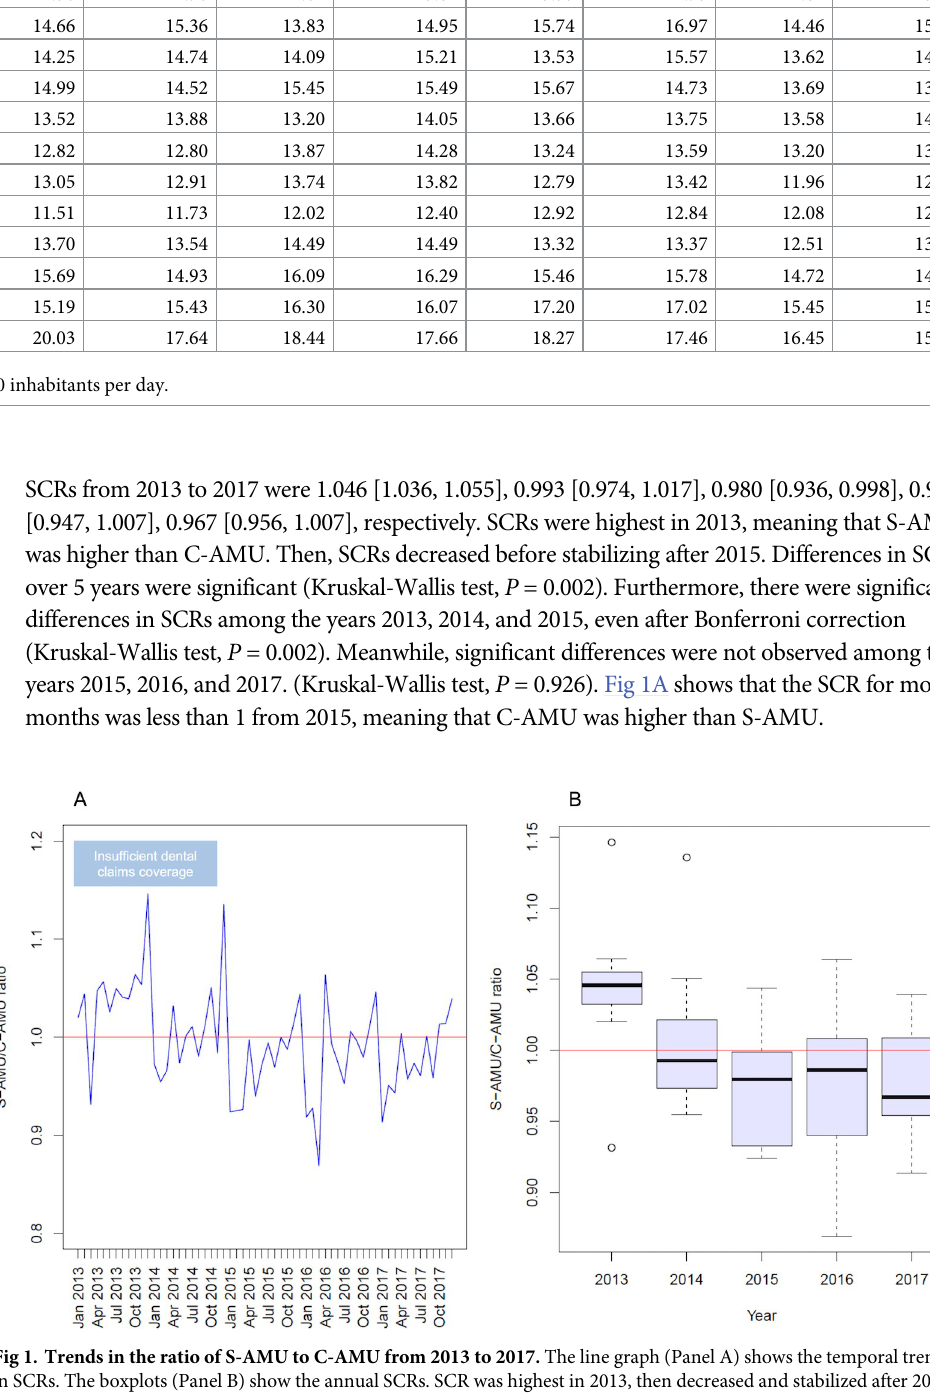
Fig 1. Trends in the ratio of S-AMU to C-AMU from 2013 to 2017. The line graph (Panel A) shows the temporal trends in SCRs. The boxplots (Panel B) show the annual SCRs. SCR was highest in 2013, then decreased and stabilized after 2015. Difference in SCRs over 5 years were significant ( P = 0.002). SCRs were significantly different among the years 2013, 2014, and 2015 ( P = 0.002), but not among the years 2015, 2016, and 2017. ( P = 0.926).